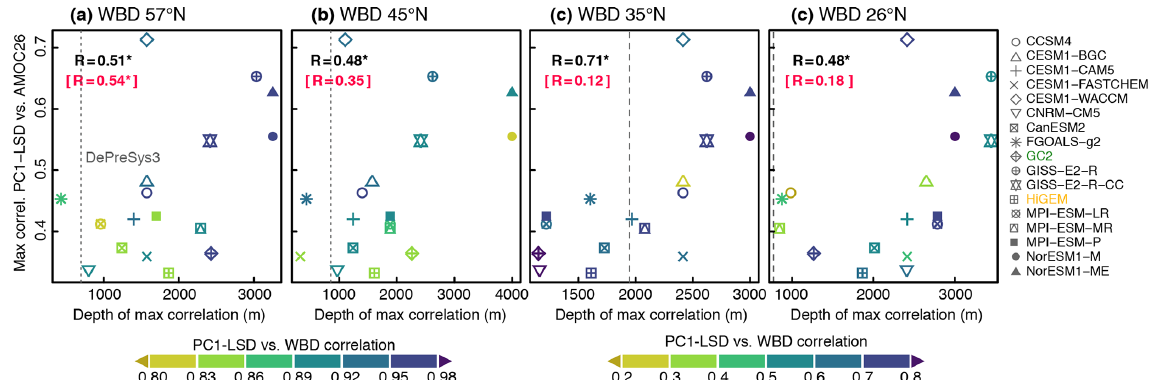
Figure 11. (a) Scatterplot of the maximum cross-correlation value in Fig. 4b between PC1-LSD and AMOC26 (without the Ekman com- ponent) against the depth at which the maximum correlations at any lag between PC1-LSD and the WBD at 57 ◦ N occur. The maximum correlations are based on 10-year running trends. The correlation coefficient between the two metrics is shown in black the top left corner. Likewise, another correlation coefficient is shown in magenta, computed between the PC1-LSD and AMOC26 maximum correlation and the PC1-LSD and WBD at 57 ◦ N maximum correlation. The presence of an asterisk indicates that the correlation is significant at the 95% confidence level. Colours indicate the maximum correlation between PC1-LSD and the WBD. The grey vertical lines depict the correspond- ing depth of maximum correlation for the DePreSys3 assimilation run. (b–d) The same as in (a) but for the WBD at 45, 35, and 26 ◦ N,